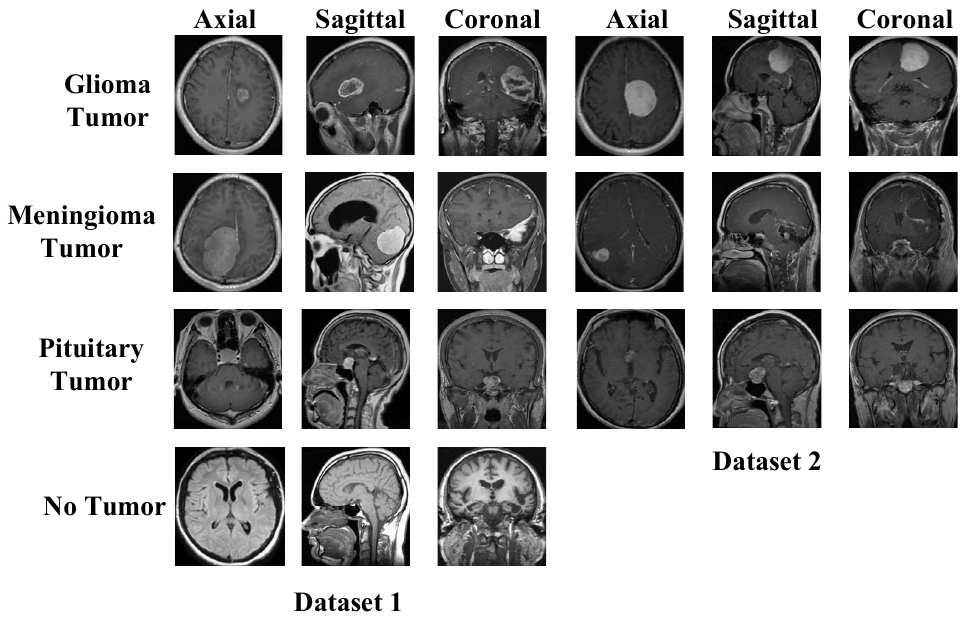
Figure 1. Sample images used in the two datasets. Dataset I: Kaggle dataset and this dataset have been used for training, Dataset II: Figshare dataset.